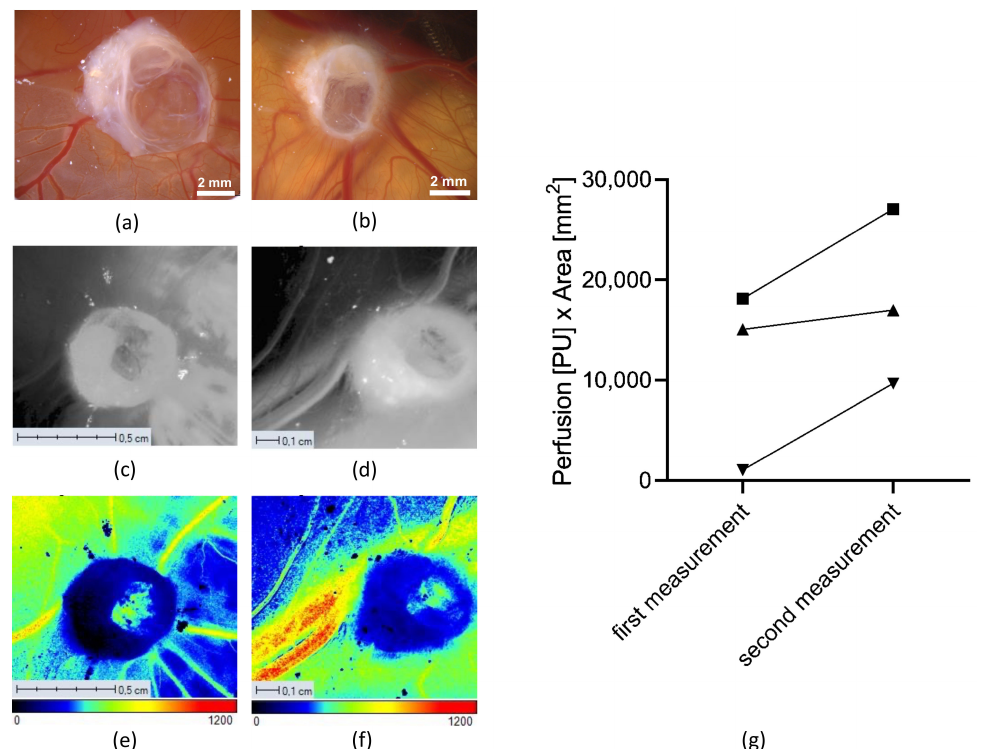
Figure 6. Angiogenesis measurements. Microscopic pictures of the CAM with renal cystic tissue after engraftment ( a ) and before removal ( b ). Monochrome intensity images of the same tissue ( c , d ) and LSCI perfusion images ( e , f ) (a color bar illustrates the perfusion scale) five days after engraft- ment ( c , e ) and on the day of removal ( d , f ). The diagram ( g ) shows an increase in the perfusion of three different cystic tissues between the two measurement days ( n =